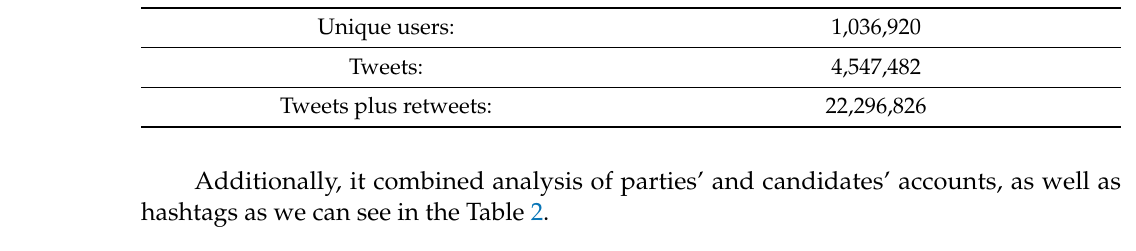
Table 1. Capture time interval: [2019/04/16 10:15:00 UTC, 2019/05/09 10:59:19 UTC].